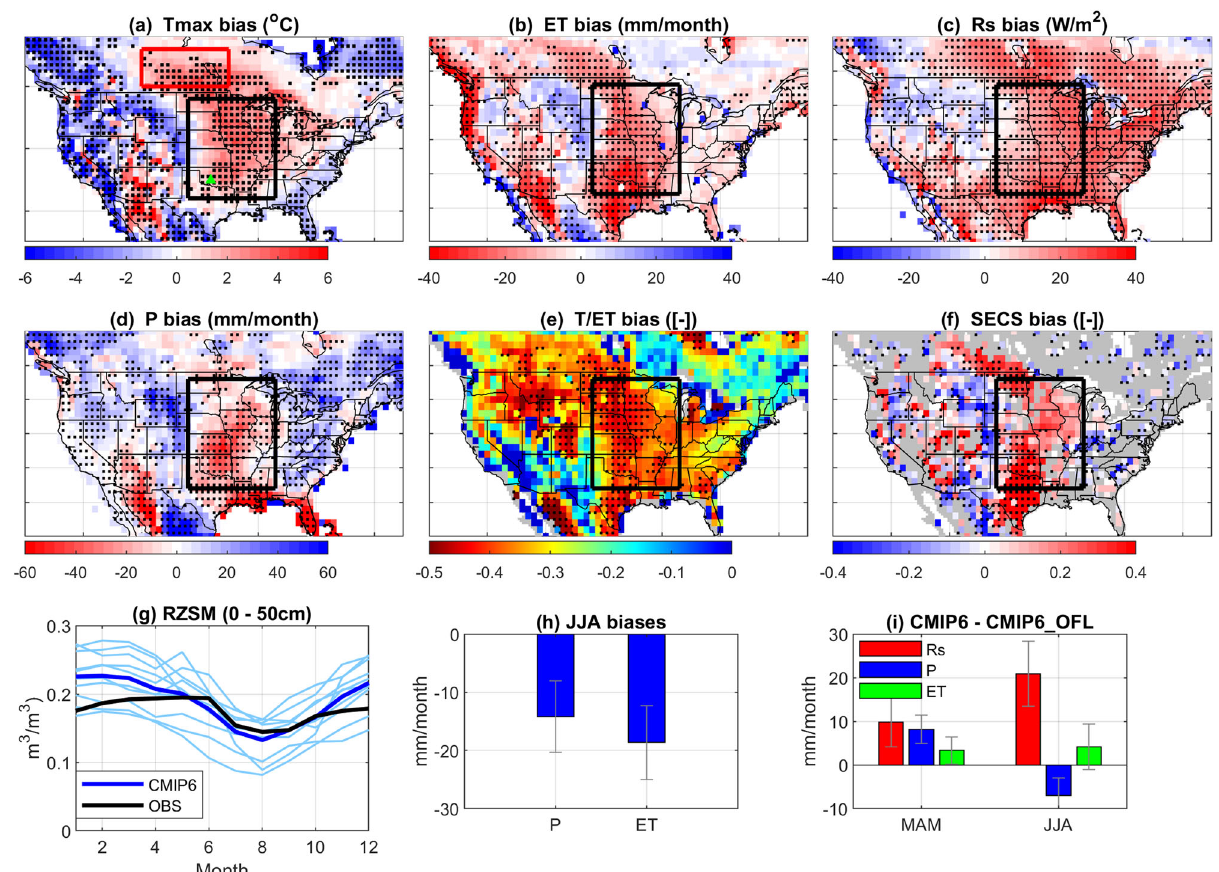
Fig. 1 Spatial distribution and temporal evolution of CMIP6 biases. 2000 – 2014 CMIP6 biases within JJA (June-July-August): Tmax (2-m summertime daily maximum temperature, a ), evapotranspiration (ET, b ), net shortwave radiation (Rs, c ), precipitation (P, d ), Global Land Evaporation Amsterdam Model (GLEAM) evaluated transpiration (T) to ET ratio (T/ET, e ) and soil moisture — ET coupling strength (SECS, f ) estimates. Dotted grids indicate that two-thirds of individual Earth System Model (ESM) biases are consistent in sign (in ( a ) – ( d ) and ( f )) or two-thirds of ESMs are 0.3 lower than GLEAM- based T/ET (in ( e )). g Monthly mean CMIP6 (Coupled Model Intercomparison Project Phase 6) RZSM (rootzone soil moisture) estimates compared to a dense soil moisture network (OBS) within the state of Oklahoma (see the green triangle in part a ). The thin and thick blue lines represent individual ESMs and their multi-model medians, respectively. h June – July – August (JJA) CMIP6 P and ET biases averaged across 15 CMIP6 ESMs. Error bars denote their inter-model standard deviations. i The mean difference of CMIP6 and CMIP6_OFL (CMIP6 off-line simulations) based Rs, P, and ET estimates for three individual ESMs during both March-April-May (MAM) and JJA. Error bars represent the range of CMIP6 and CMIP6_OFL differences. All ET bias results use FluxCOM as a baseline reference; however, no qualitative change is found when a different ET reference is used instead (see Supplementary Fig.